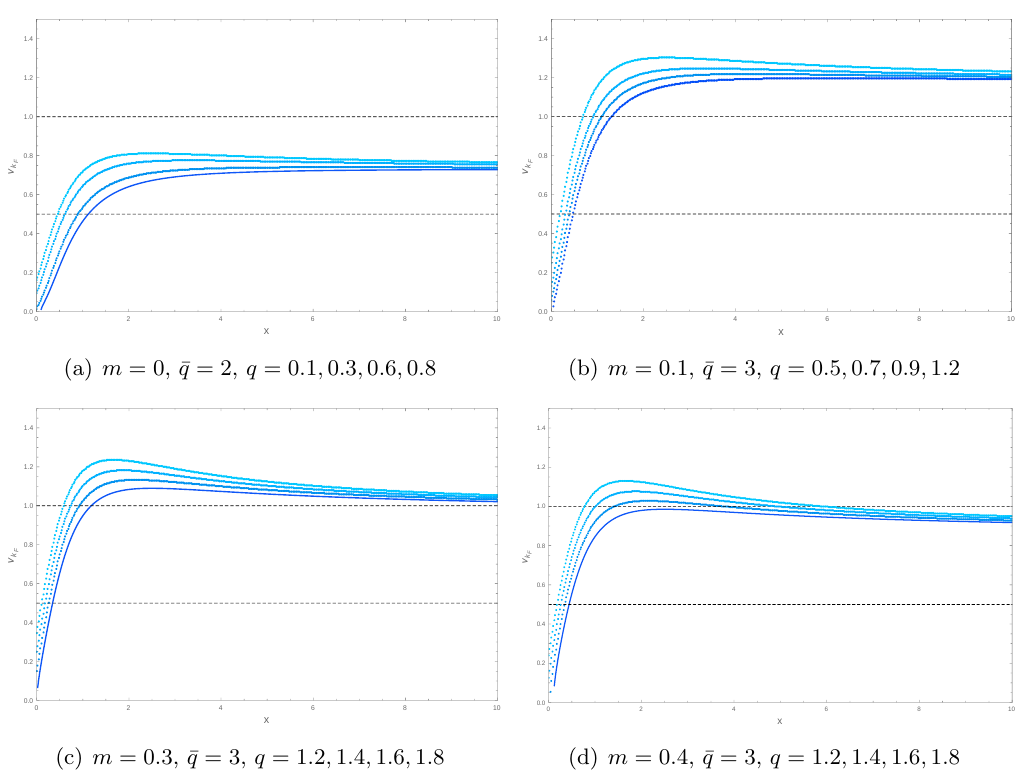
Figure 1 . The index (cid:23) k as a function of the doping x . Each plot corresponds to a (cid:12)xed value F of the spinor mass m and charge (cid:22) q , and shows di(cid:11)erent values of the charge q decreasing from the top curve to the bottom one. The dashed horizontal lines denote (cid:23) k = 1 = 2 and (cid:23) k = 1. In F F all cases, there is a critical value of the doping at which (cid:23) k reaches the value 1 = 2 and long lived F quasiparticles begin to exist. When the mass m is non-vanishing, there is a larger value of the doping at which (cid:23) k reaches the value 1 and the quasiparticle lifetime scales with the frequency as F that of a Landau Fermi